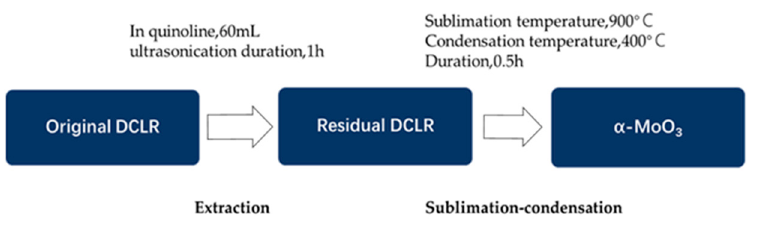
Figure 7. Flow diagram with optimal recycle parameters.